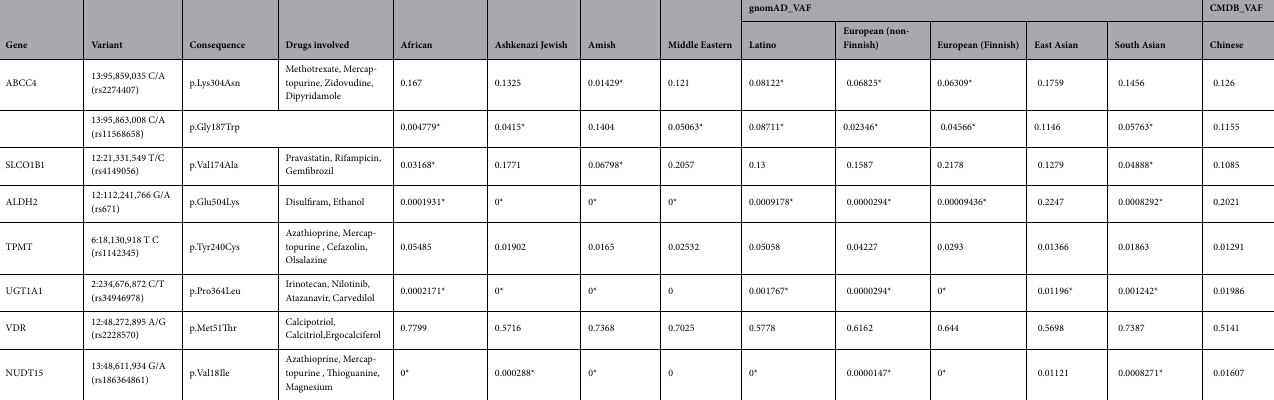
Table 1. VAF with clinical relevance in CMDB Chinese and diverse gnomAD populations. VAF variant allele frequency, CMDB Chinese Millionome Database, gnomAD Genome Aggregation Database, ABCC4